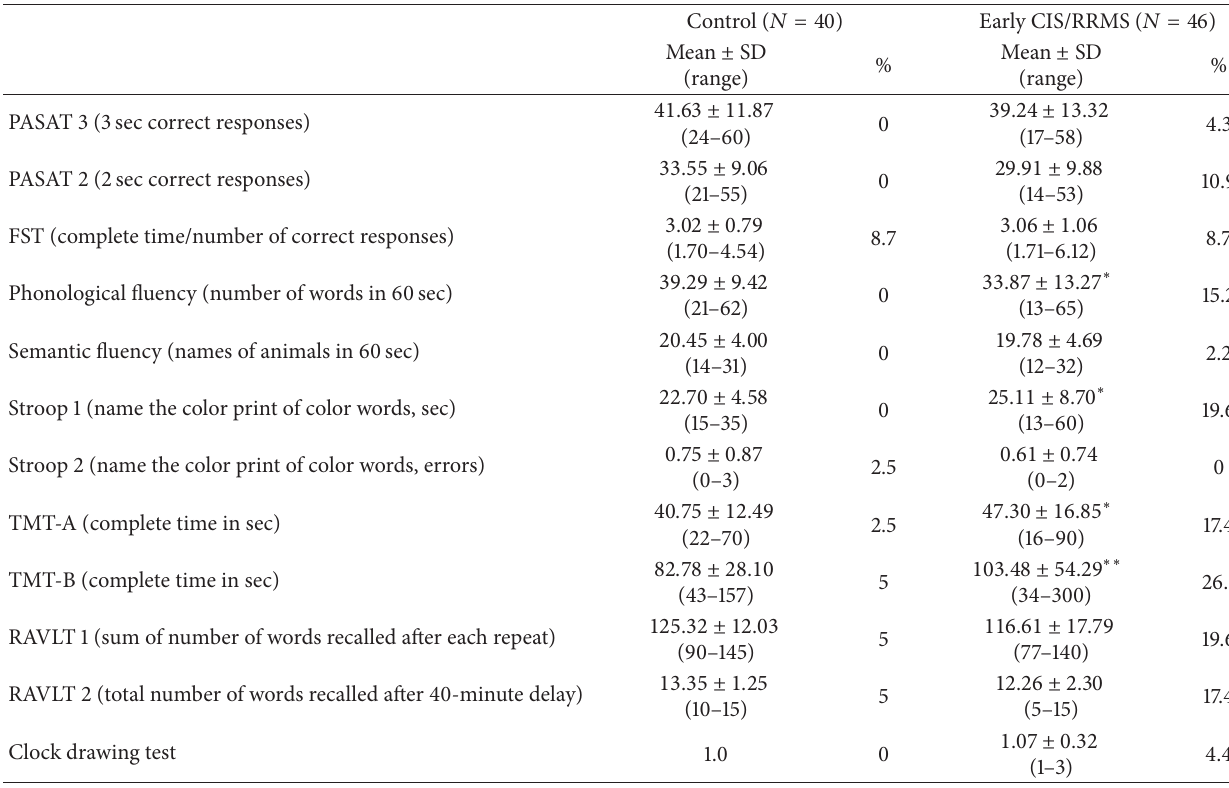
Table 2: Neuropsychological tests used and raw performances for healthy controls and patients. Results are expressed as percentages of controls and patients whose scores were outside the normal range for each cognitive